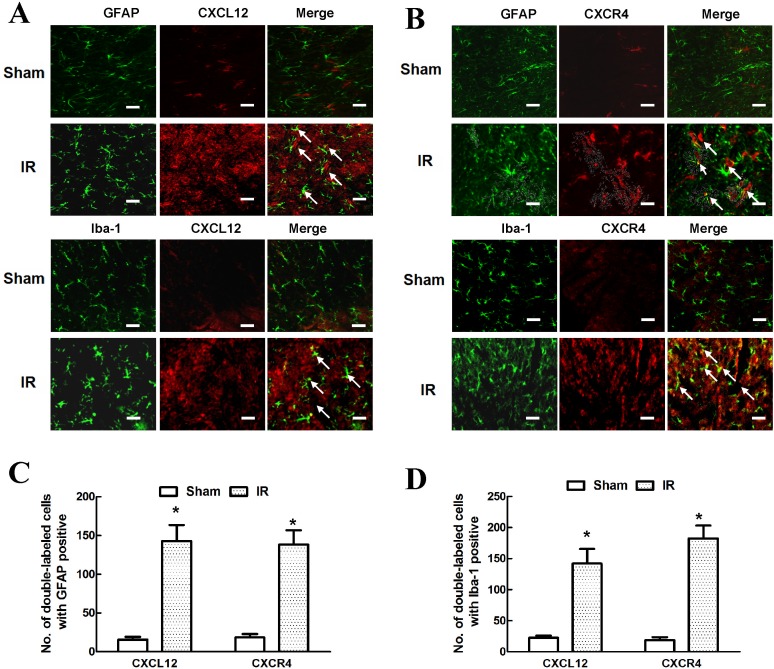
Glial localization of CXCL12/CXCR4 expression in the spinal cord after IR-induced pain.(A) Representative immunofluorescent localization of astrocytes (GFAP; green), microglia (Iba-1; green) and CXCL12 (red) in the spinal cords of the sham-operated or operated rats at 48 h post-surgery. (B) Representative immunofluorescent localization of astrocytes (GFAP; green), microglia (Iba-1; green) and CXCR4 (red) in the spinal cords of the sham-operated or operated rats at 48 h post-surgery. Scale bars represent 100 μm. (C) Quantification of double-labeled, GFAP-positive cells in the spinal cord. (D) Quantification of double-labeled, Iba-1-positive cells in the spinal cord. Double immunofluorescence showing that CXCL12/CXCR4 expression was up-regulated in IR-induced pain and highly co-localized with astrocytes and microglia. Data are expressed as the mean ± SD. *P < 0.05 vs. the sham group.